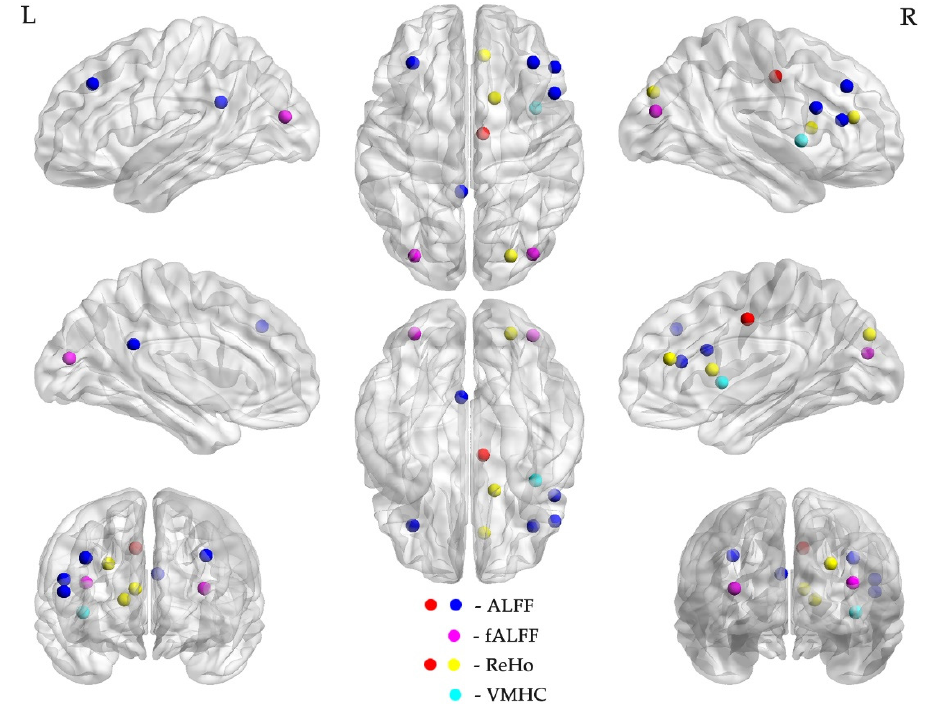
Figure 2. The selected ALFF, fALFF, ReHo and VMHC features for discriminating the SCC from BC group. Abbreviations: ALFF, amplitude of low frequency fluctuation; fALFF, fractional ALFF; ReHo, regional homogeneity; VMHC, voxel-mirrored homotopic connectivity; L, left; R, right.